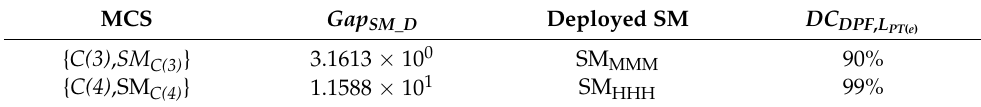
Table 6. Safety mechanism deployment for the PT according to DC DPF , L MCS Gap SM_D Deployed SM DC DPF , L